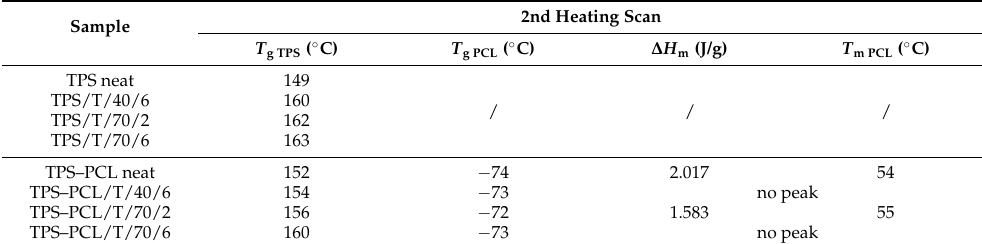
Table 4. Thermal parameters of TPS and TPS–PCL blends from